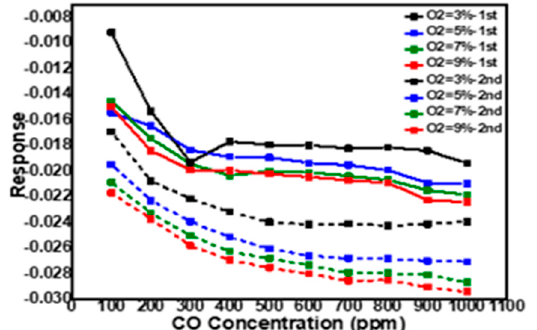
Figure 1. Response of the Pt/Al 2 O 3 sensor when exposed to CO from 100 to 1000 ppm in 100 ppm steps at 3–9% O 2 in N 2 at 500 °C. Solid lines indicate first measurements, and dashed lines indicate second measurements.